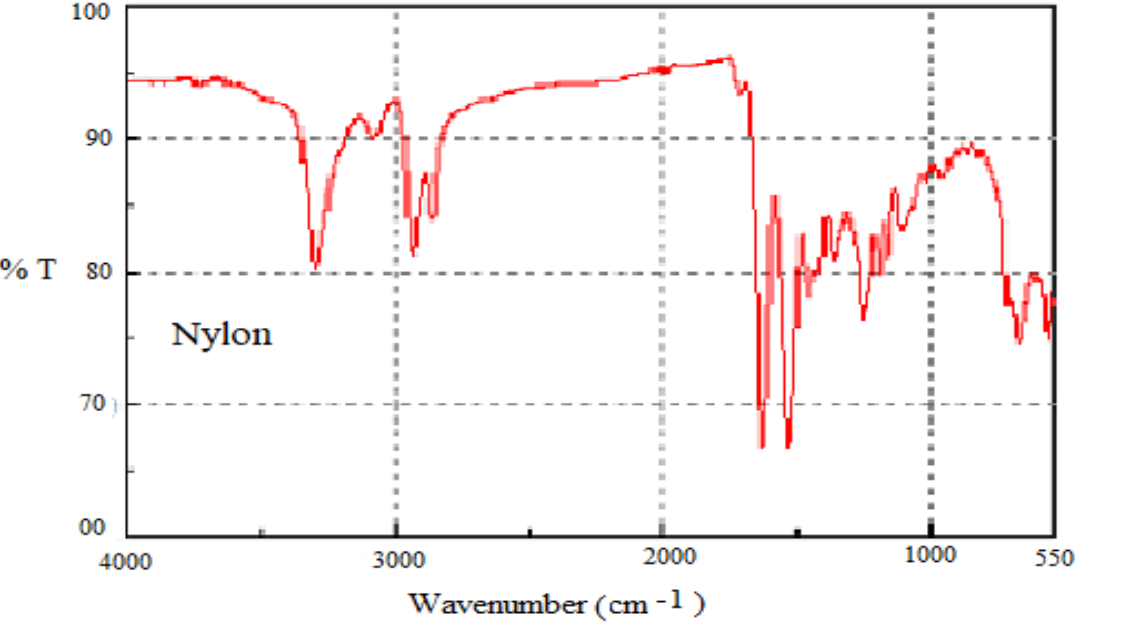
Figure 1. FTIR results for the Nylon 6/6.